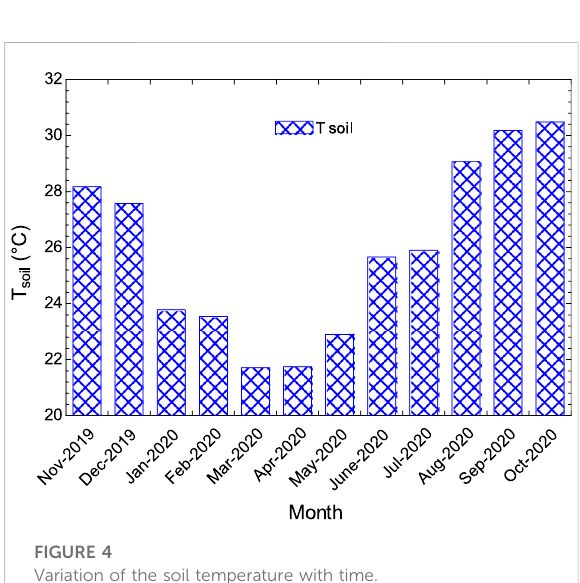
FIGURE 4 Variation of the soil temperature with